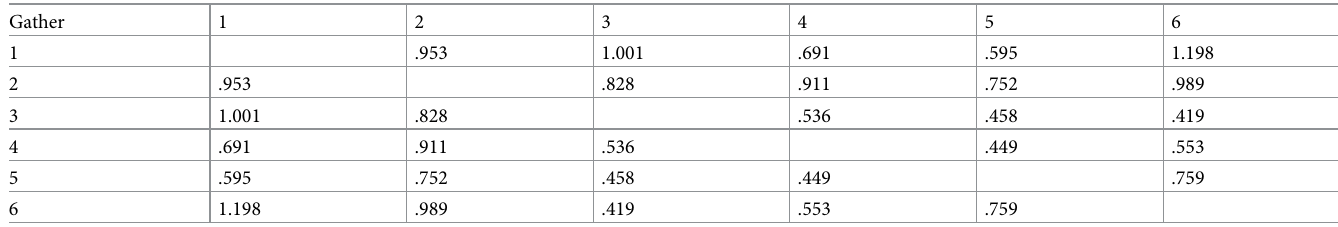
Table 3. Distance from the final aggregation center.